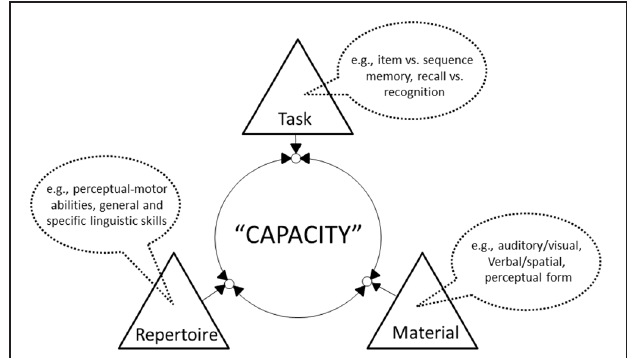
FIGURE 1 | Schematic illustration of the framework, within which performance is a dynamic outcome of three broad classes of factor, each of which may modify the influence of each of the